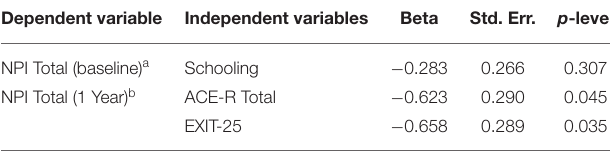
TABLE 5 | Linear regression analysis for NPI total score (baseline and 1-year follow-up) among AD patients. Dependent variable Independent variables Beta Std. Err. p